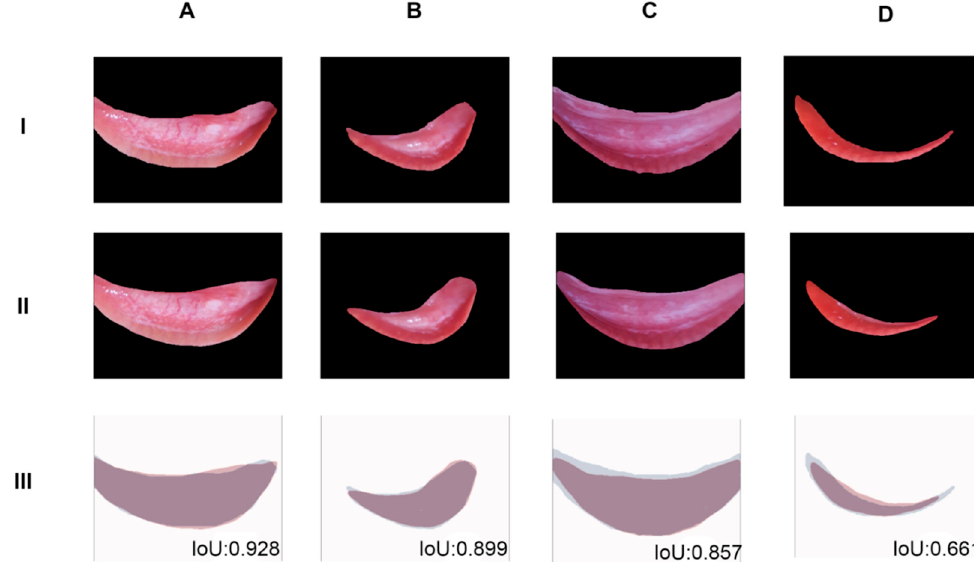
Figure 8. Four samples ( A – D ) of the segmentation results. Row I: The manually segmented conjunctive region, Row II: Segmented conjunctive region by the model, and Row III: Overlay of both the masks and IoU.